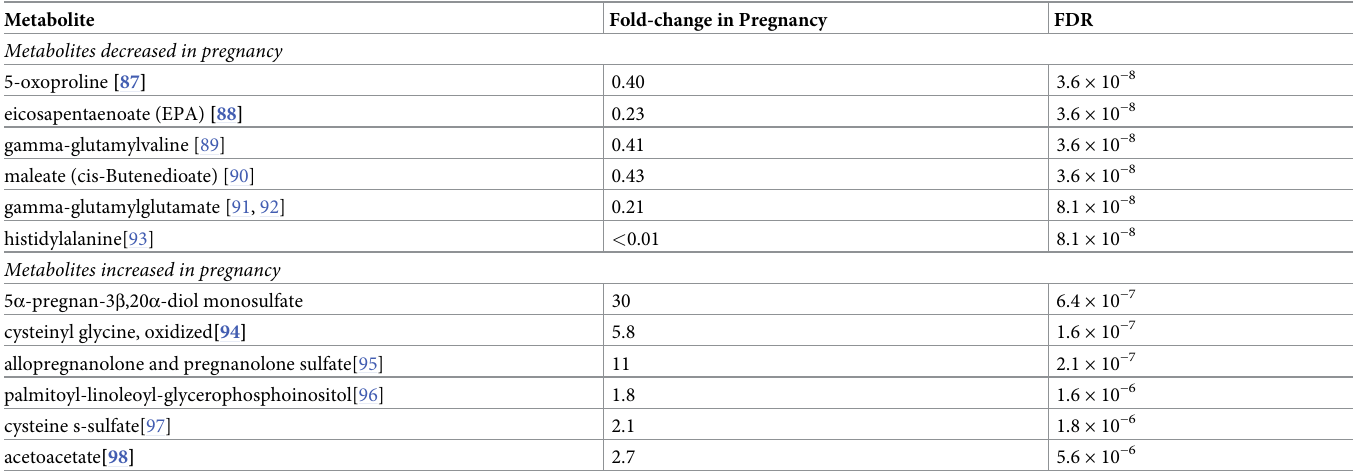
Table 2. Differences among the most-consistent metabolites abundance in pregnancy.